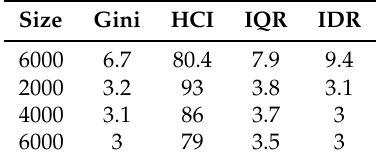
Table 1. Relative mean bias (%) of each parameter without applying PSA.